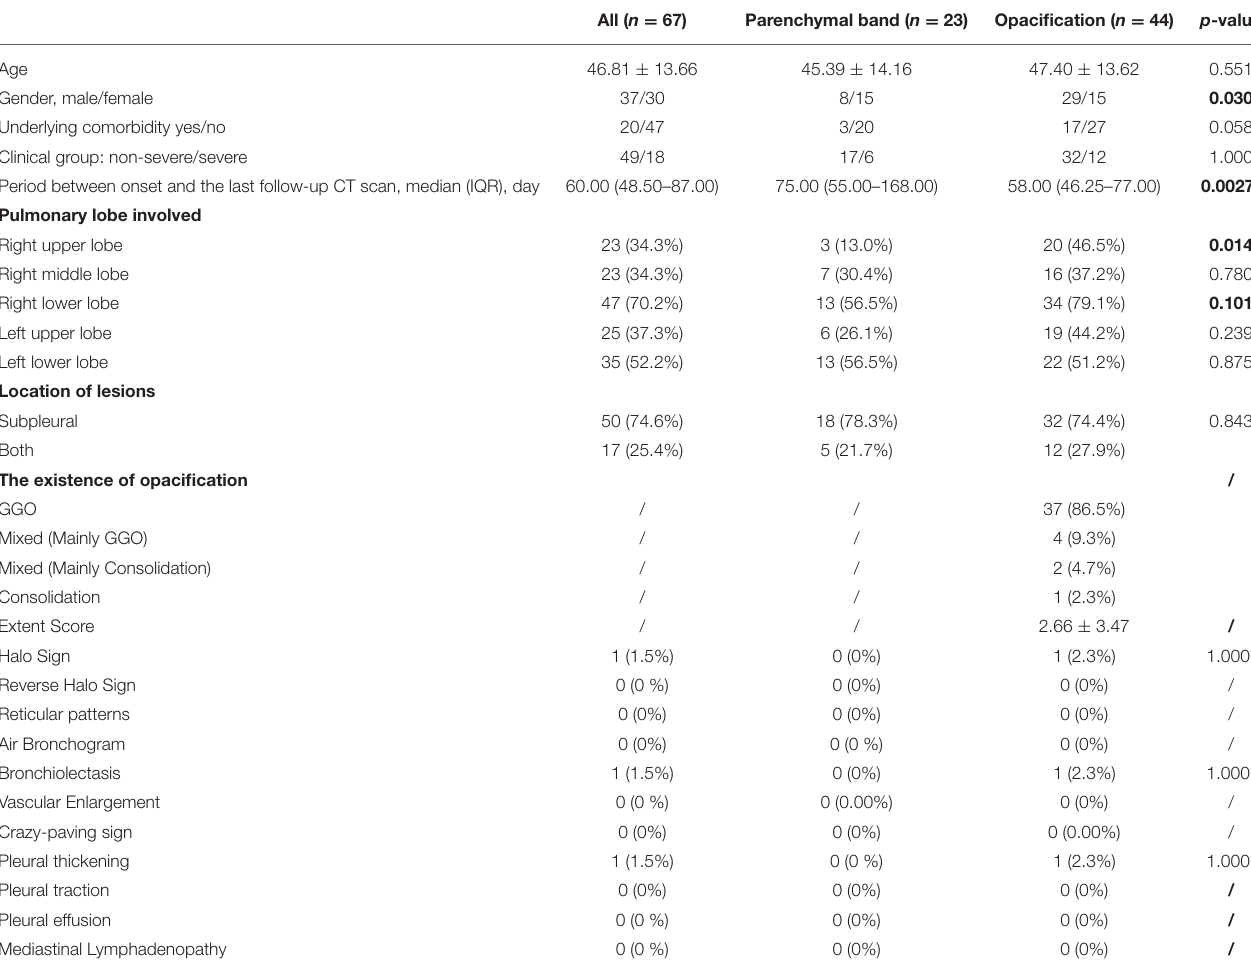
TABLE 4 | The clinical baseline and CT manifestations from the last scan in patients with COVID-19 with incomplete absorption status after